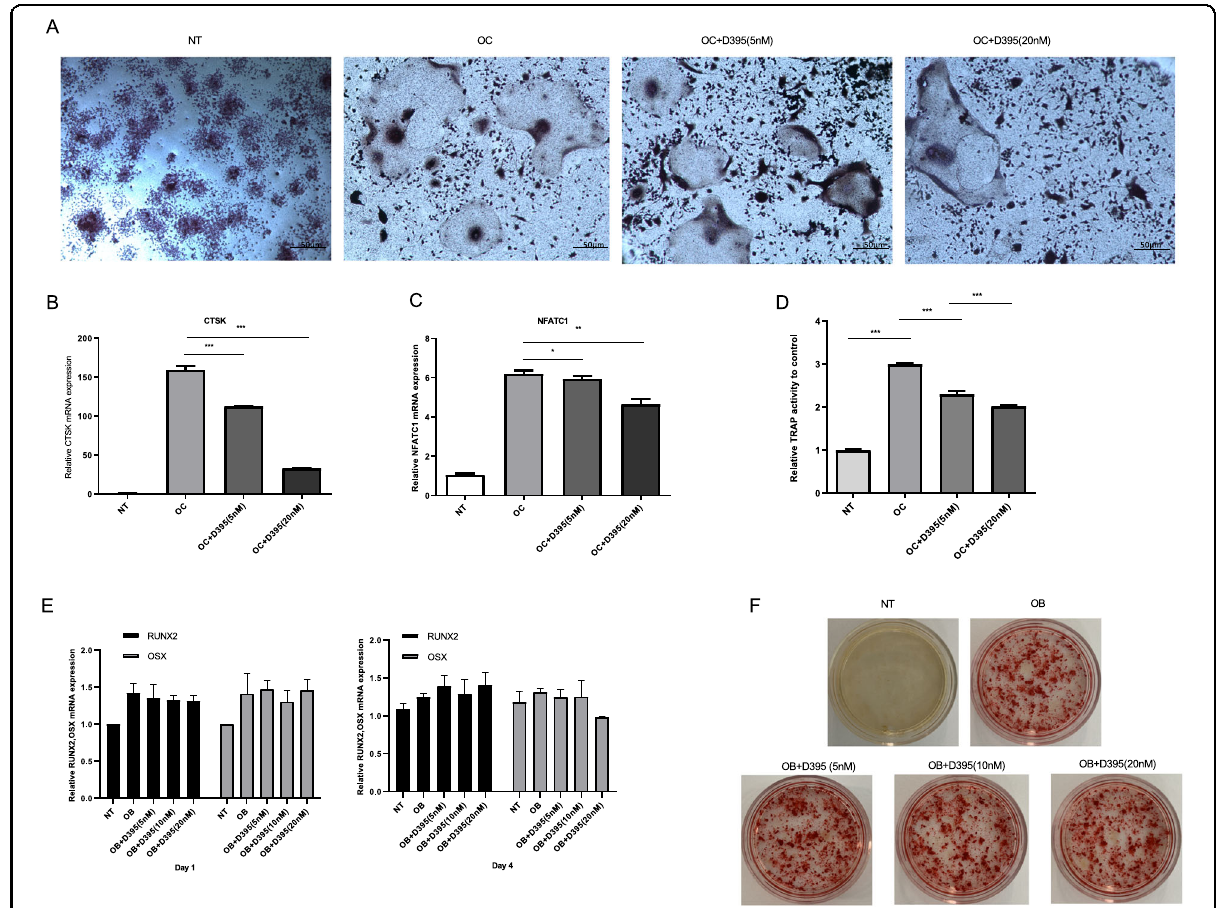
Fig. 6 Effects of D395 on osteoclast and osteoblast differentiation. A Raw264.7 cells were differentiated into osteoclasts stimulated with RANKL (10 ng/ml) and different dose of D395 at the indicated time. TRAP staining was performed at day 5, and osteoclasts were characterized as multinucleated ( ≥ 3) (scale bar = 50 μ m). B , C qRT-PCR was used to examine the expression of genes related to osteoclast formation, including Ctsk and Nfatc1 . D TRAP activity in the supernatant of osteoclast cells was detected by Tartrate-Resistant Acid Phosphatase Assay Kit on day 5. E MC3T3-E1 cells cultured in osteogenic medium with different concentrations of D395 were used for osteoblast differentiation. The expression of genes related to osteogenesis was examined by qRT-PCR at day 1 and day 4. F Alizarin red S staining was performed on day 21 to assess osteoblast differentiation. (NT, no treatment group; OC, osteoclast formation positive control with RANKL (10 ng/ml)